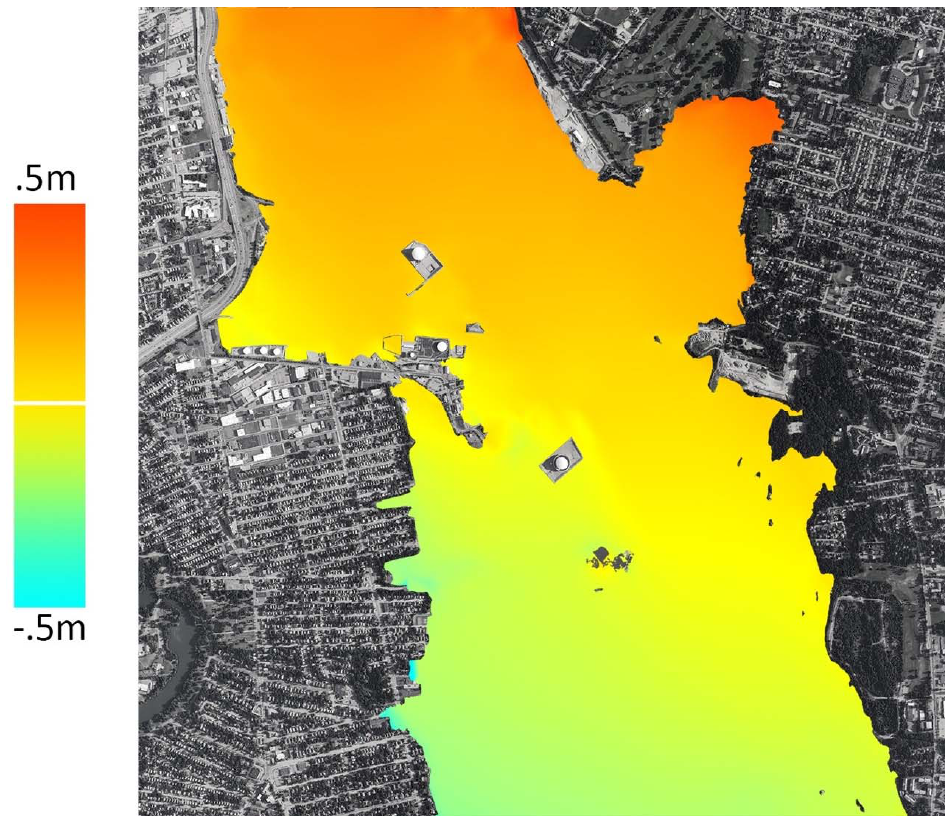
Figure 11. Variation from mean sea surface elevation during a modeled inundation event. Total variation +/ − 1 m; total area shown 14 km 2 . Image: Authors (Air photo: RIGIS).